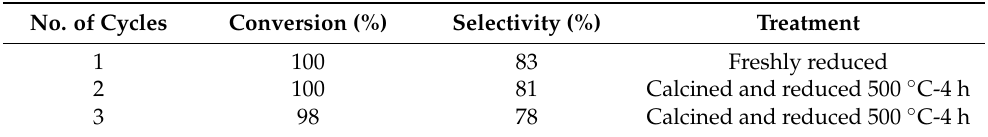
Table 5. Recyclability test of Ni/HZ-0.5 M catalyst in citral hydrogenation.